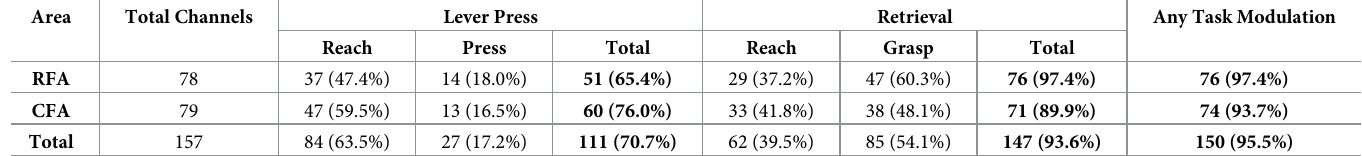
Table 3. Summary of significant task-related changes in high-gamma band (70-110Hz)